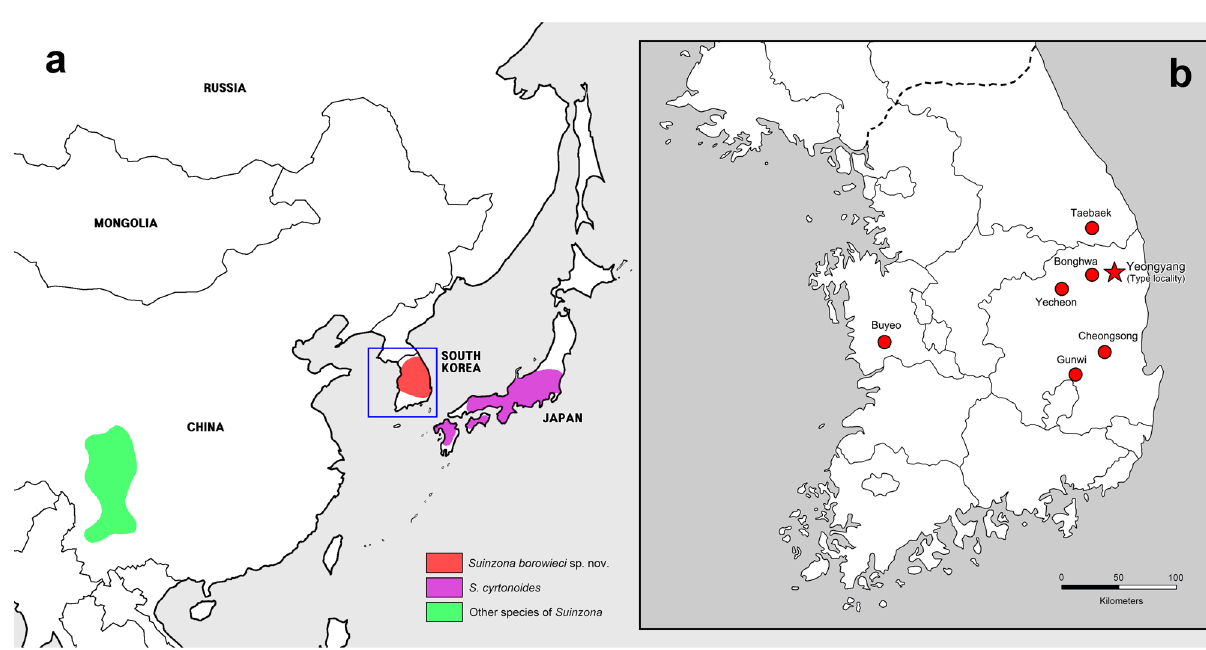
Figure 3. Distribution map of Suinzona and sampling sites: (a) Distribution of Suinzona species in China, South Korea and Japan, (b) type locality and collection sites of Suinzona borowieci sp. nov. in South Korea. Records of distribution are taken from Ge et al. 3 , Suzuki et al. 21 and the results of this work. The map is redrawn and modified from National Geographic Information Institute of Korea (https:// www. ngii. go.